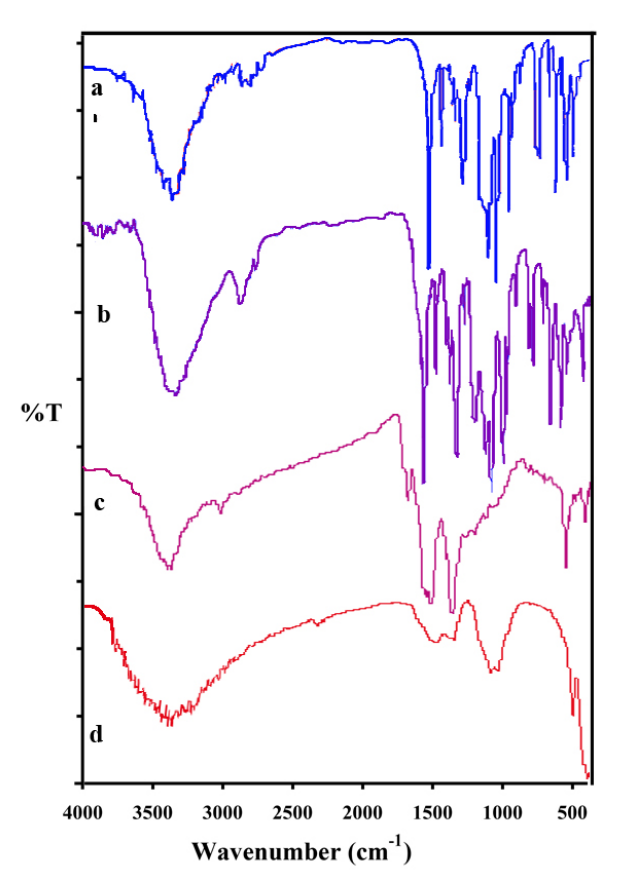
Fig. 4. FT-IR spectra of a) alizarine yellow R, b) [Gd(L) c) sample no. 1 and d) sample no.